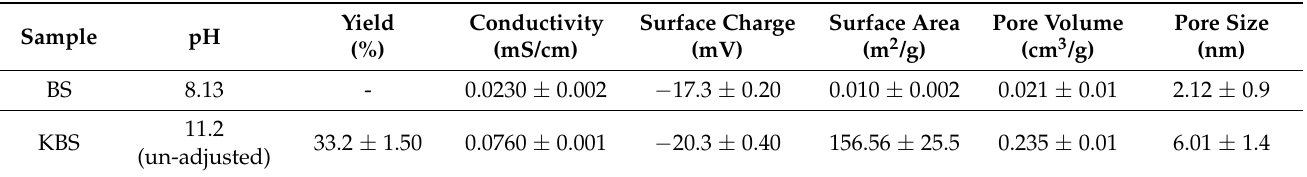
Table 1. Characteristics of biosolids before and after